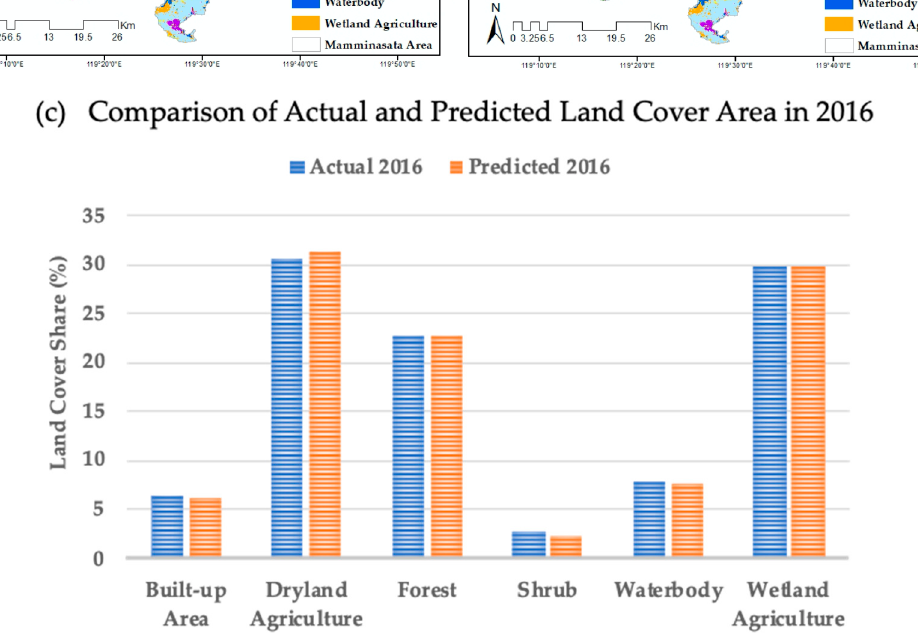
neural network and the Markov chain (MLPNN + MC) ( b ); comparison of land cover area ( c